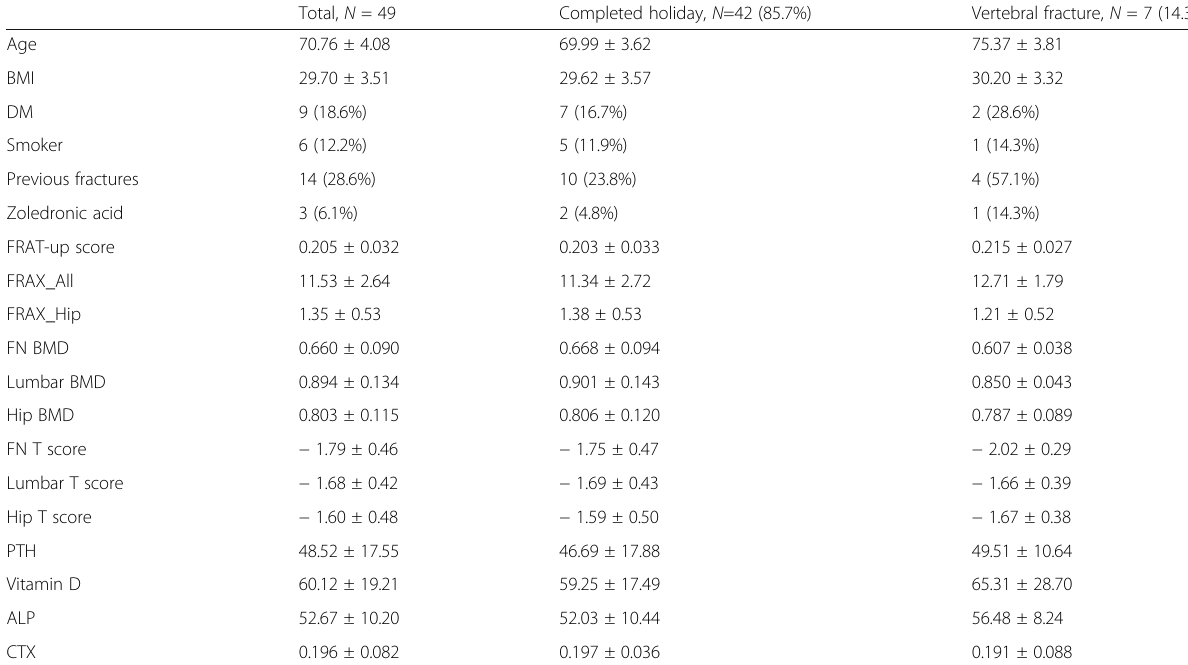
Table 1 Demographic and baseline clinical